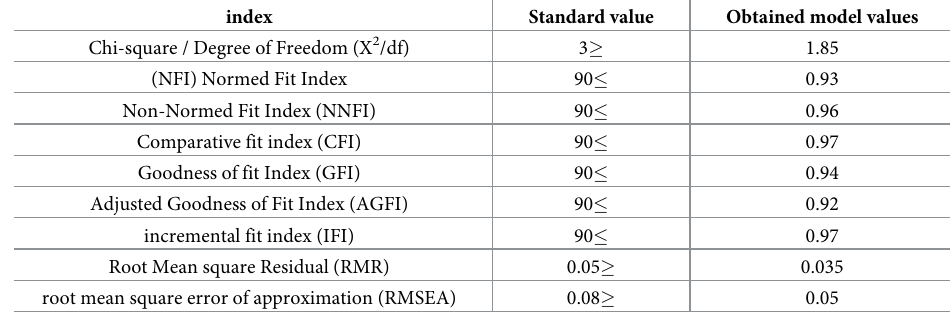
Table 6. Standard values and model fit indices.